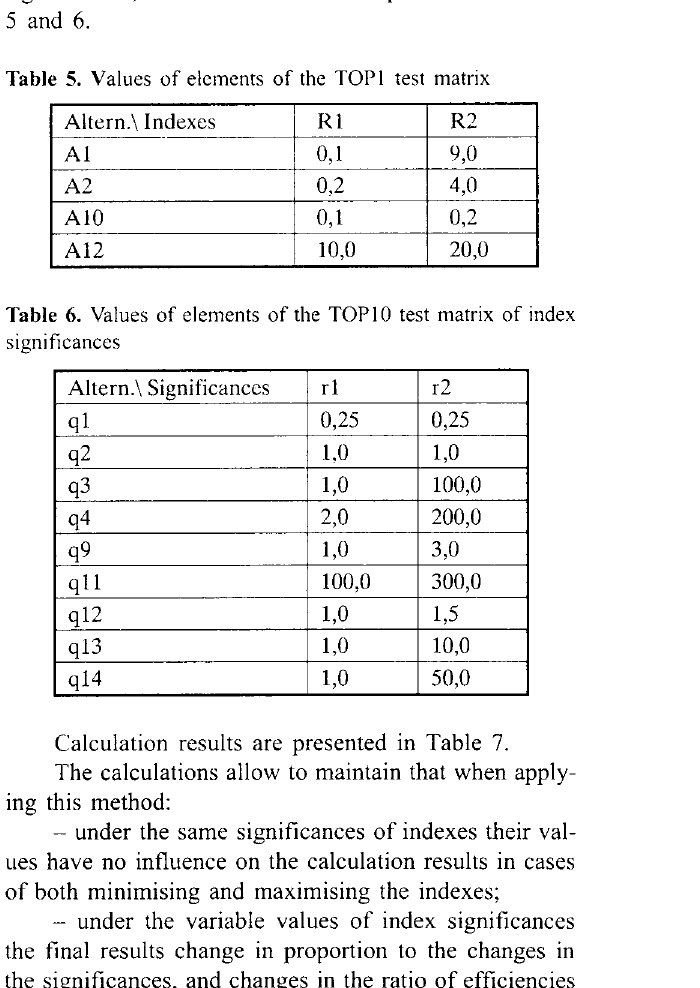
Table 5. Values of elements of the TOP! test matrix